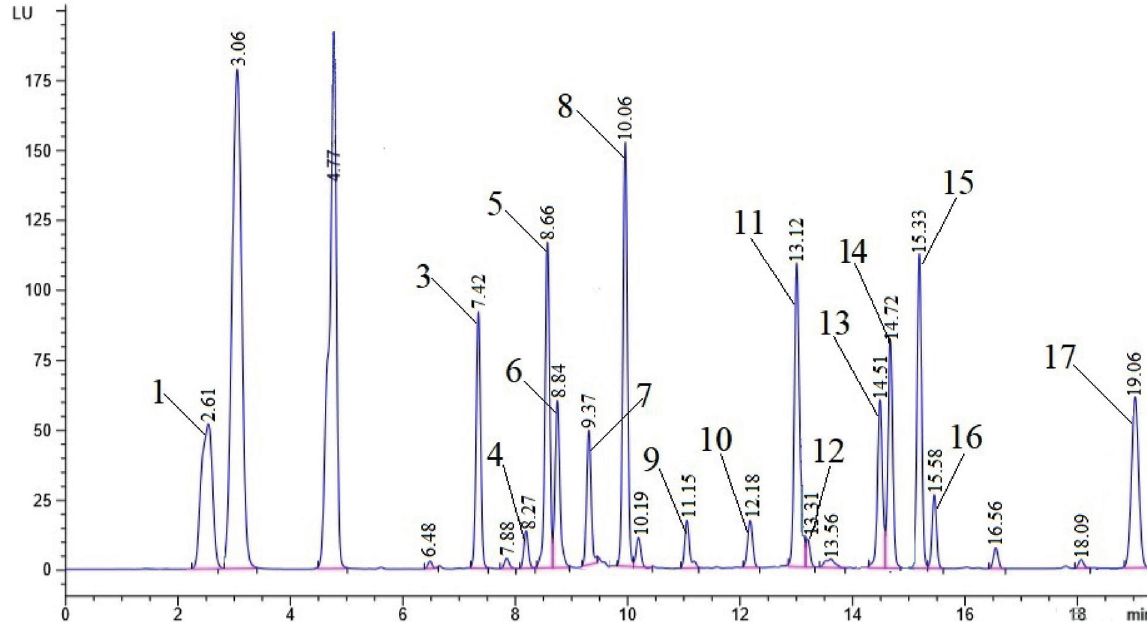
Figure 4. HPLC chromatogram of amino acids after hydrolysis of Stahys sieboldii